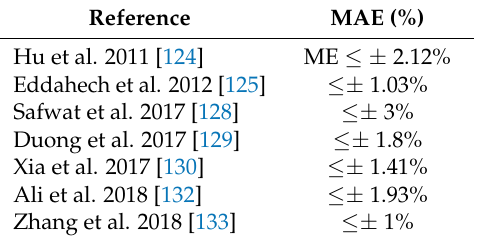
Table 11. MAE/ME of the RLS, variants of the RLS and hybrid RLS-based SOC estimation